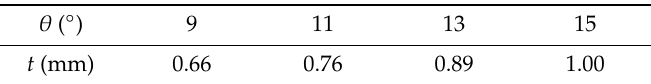
Table 2. The size of TPU model.